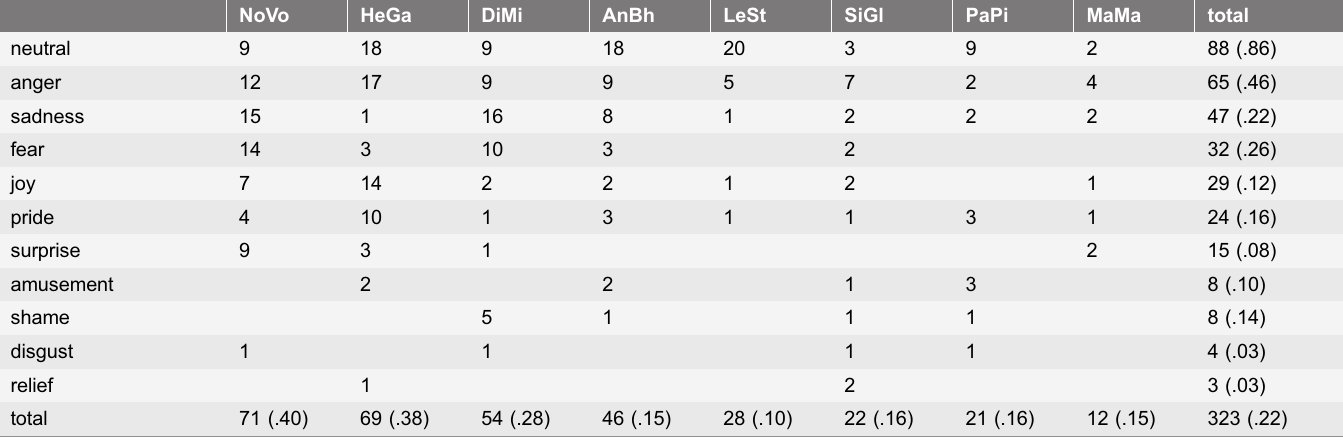
Table 7. Frequencies of motion sequences across actors where intended and perceived emotion categories coincide, sorted by the total frequency within each emotion category (rows) and actor